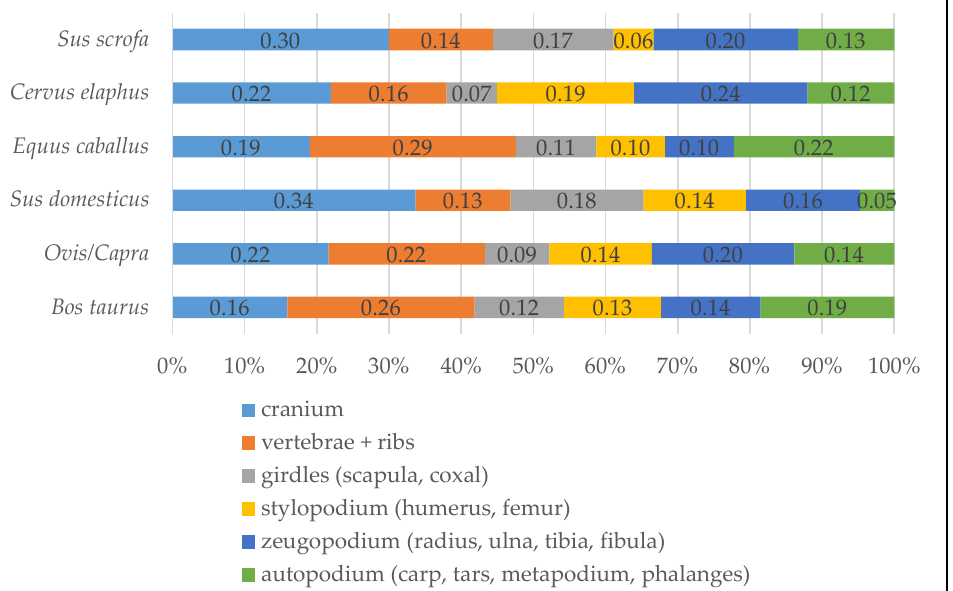
Figure 10. Halmyris, Romania, 2014, extramuros area (4th–6th centuries AD). Skeletal frequency in mammal species from extramuros sample.